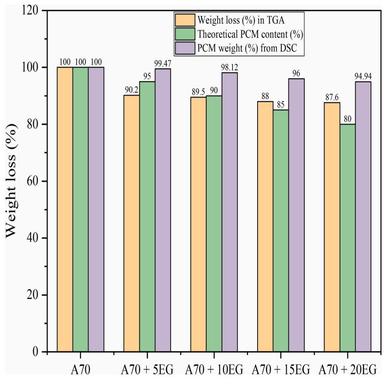
Variation in weight loss for different weight fractions of EG was added to base PCM based on the theoretical, DSC, and TGA values.